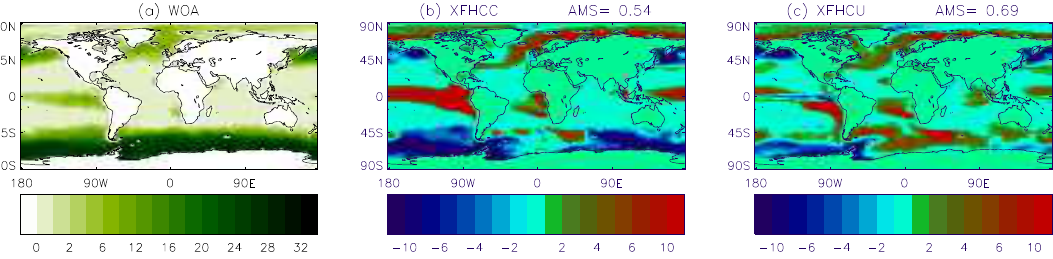
Fig. 14. Annual mean nitrate concentration in mmol per m − 3 at 5m for (a) World Ocean Atlas observations (Garcia et al., 2006) and the difference between the simulated and observed values for (b) the generation 3 model XFHCC and (c) the generation 4a model XFHCU. The AMS scores for simulations are given above (b) and (c) .